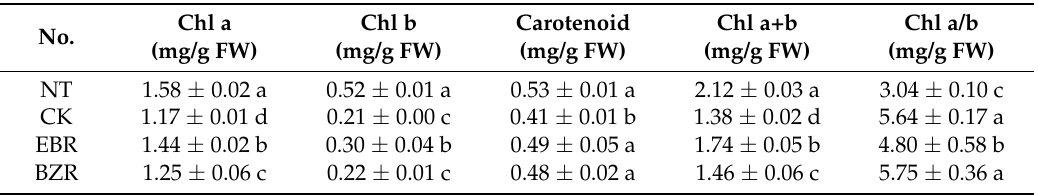
Table 1. Effect of EBR on chlorophyll content of cucumber seedlings under low-temperature stress. No.